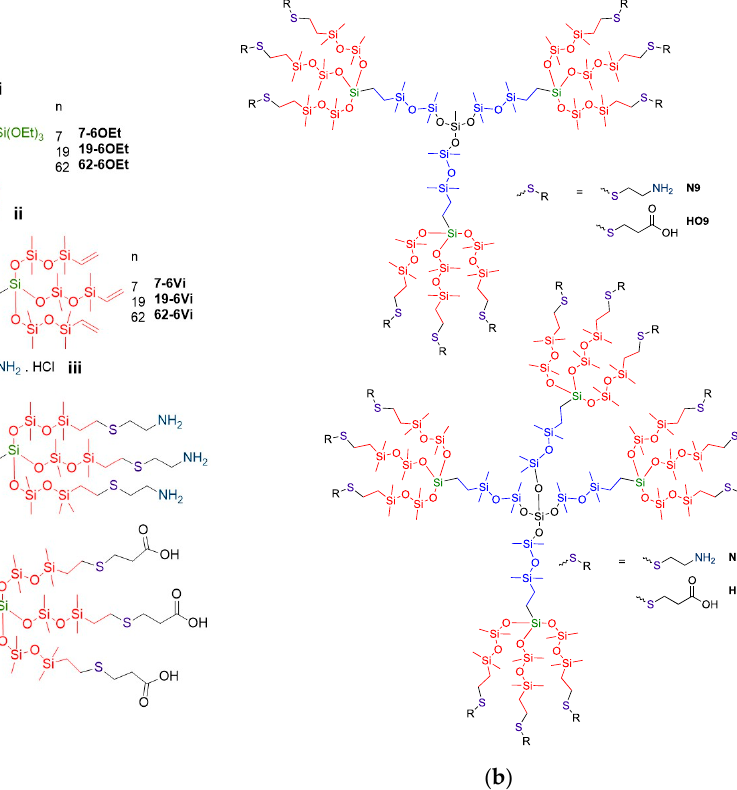
Figure 2. ( a ) The conversion of vinylsilicones into trivinylsilicones, and then sixfold cysteamine or mercaptopropionic acid-derived ligands. ( b ) Nine- and 12-fold analogues. 2.2. Chelation